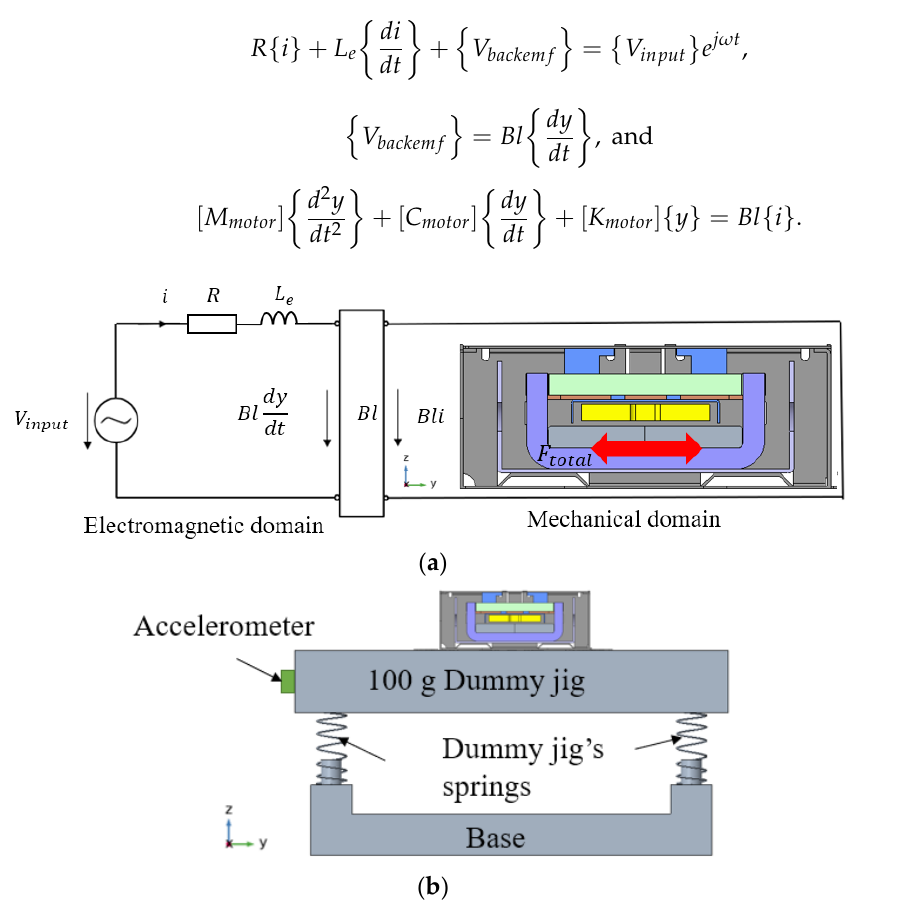
Figure 4. Analysis method: ( a ) E–M coupling method; ( b ) acceleration calculation of the HLVM. The material properties of the mechanical domain are the density, Young’s modulus and Poisson’s ratio, as shown in Table 1. The coil is made of a DHT wire (Daikoku high tension). The top plate and yoke are made of the same magnetic material, named SPCC (commercial quality cold-rolled steel), which exhibits high nonlinear magnetic permeability. SPCC is defined in JIS G 3141 (Japanese material standard for cold rolled steel). The magnetic material possesses neodymium iron boron with an N42H magnetic grade. The motor spring and dummy jig spring possess the same material as the cases. POM is the short name for polyoxymethylene, which is an engineering thermoplastic.